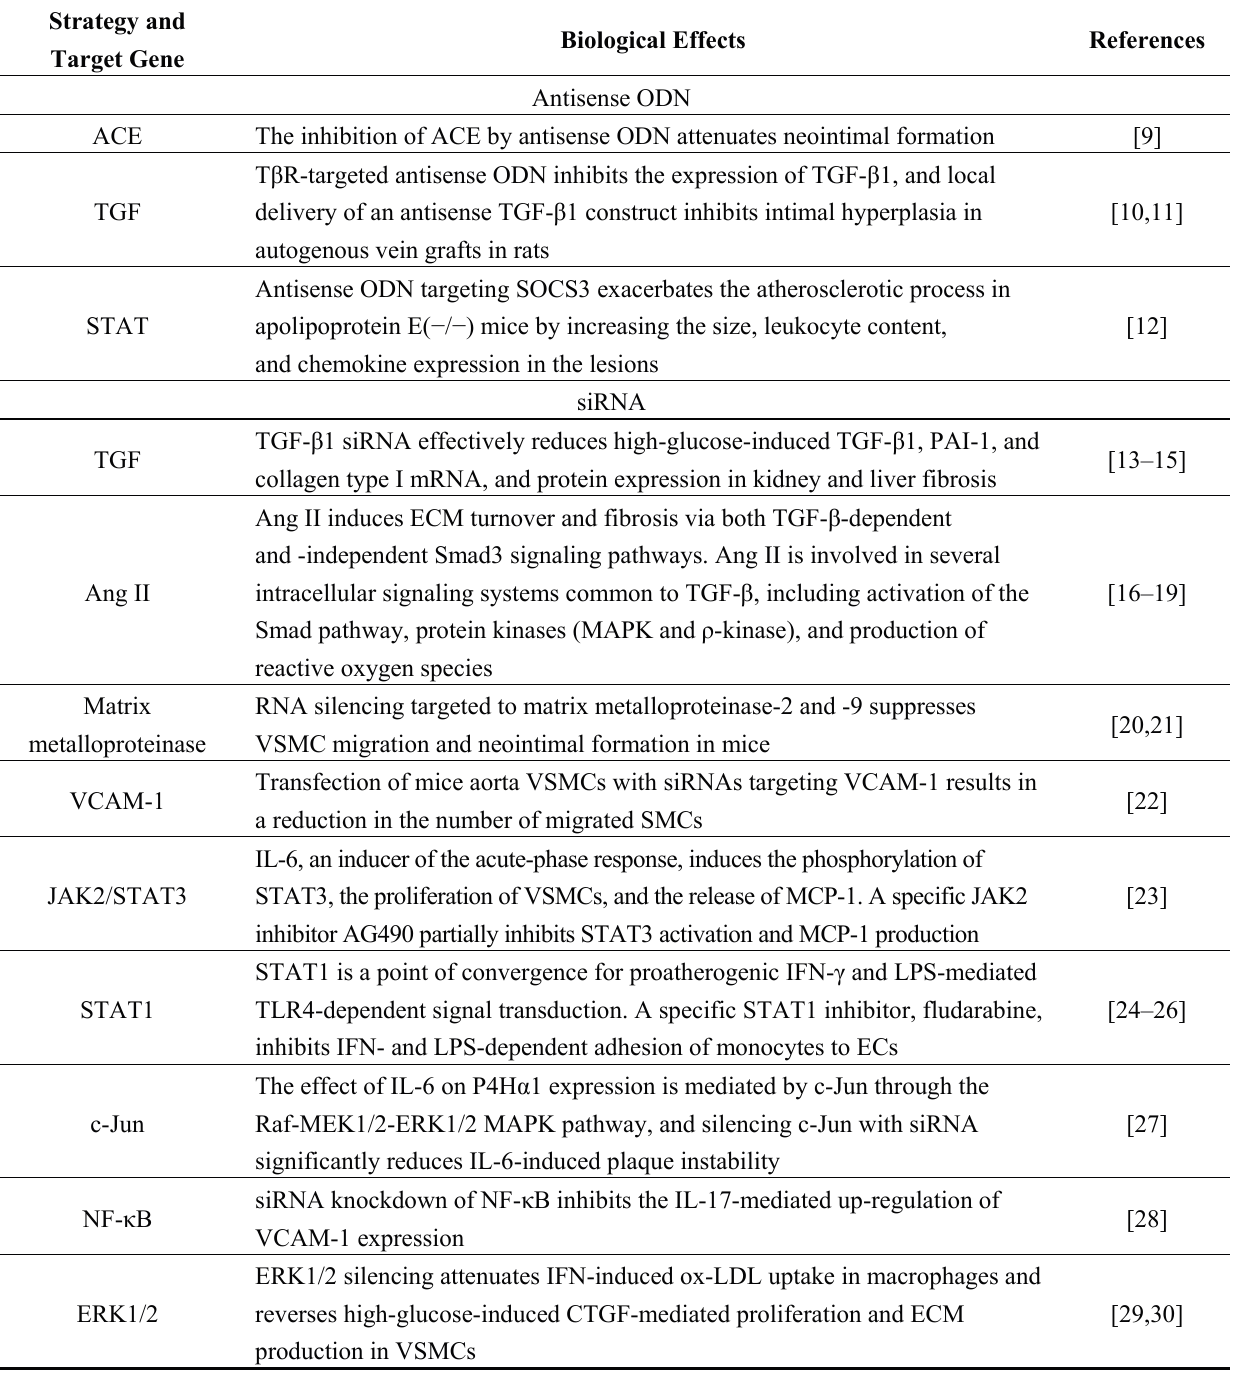
Table 1. Small-nucleic-acid-based therapeutic strategies targeting the genes regulating vascular inflammation, remodeling and fibrosis in atherosclerosis, and neointimal formation after surgical or interventional